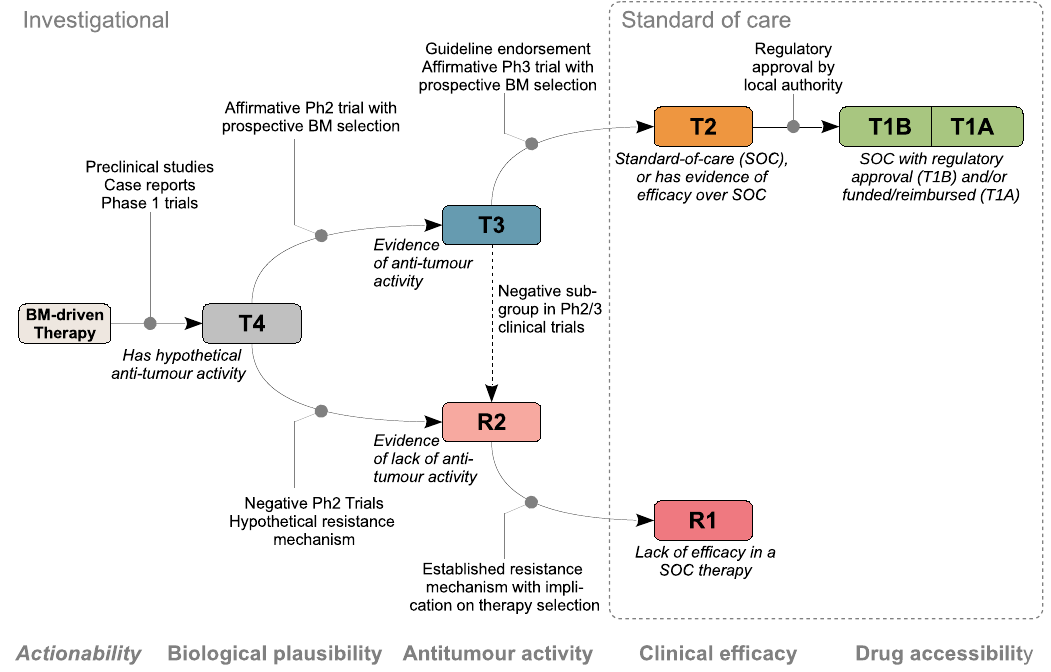
Fig. 2 Hierarchy of tiers curated in TOPOGRAPH. The de fi nition of evidence tiers in TOPOGRAPH re fl ects the maturity of a drug in its development. Tiers T1, T2, and R1 are considered standard-of-care, whereas the remaining tiers are investigational. Therapy yet to be adequately studied for possible clinical activities are designated T4. BM biomarker; Ph2 phase 2 clinical trials, Ph3 phase 3 clinical trials, SOC standard of